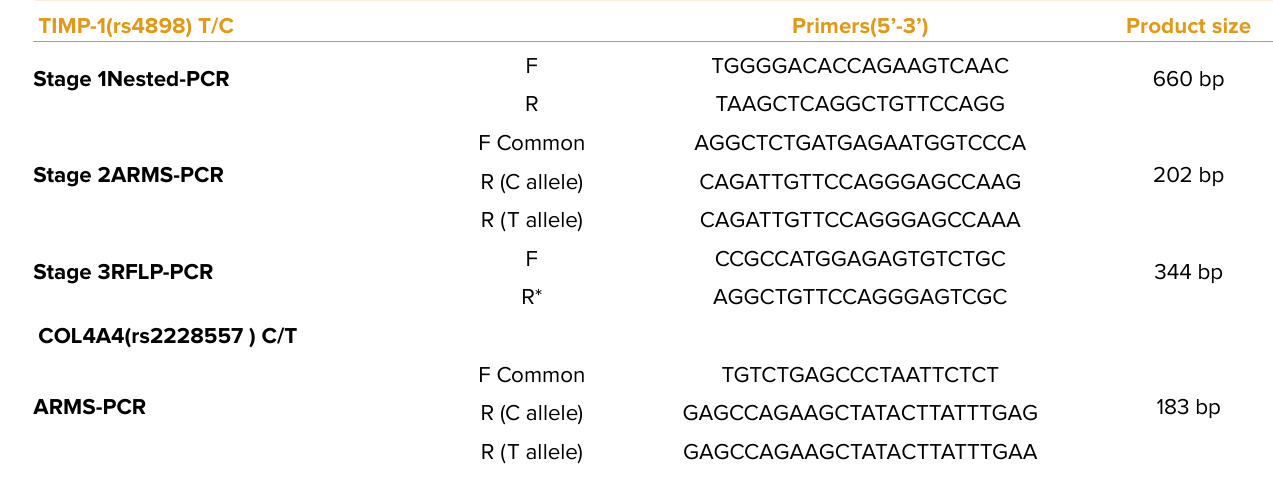
Table 1. The list of primers and methods used for detection of Single Nucleotide Polymorphisms (SNPs) TIMP-1 rs4898 and COL4A4